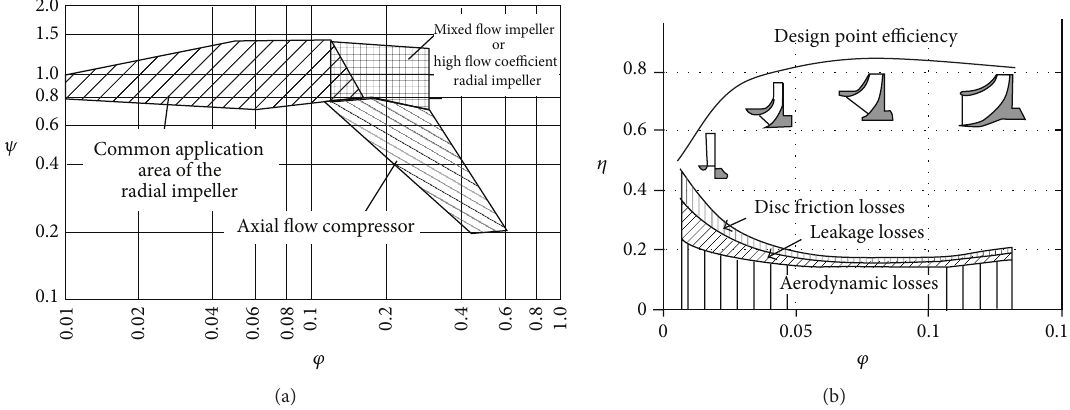
Figure 1: Application areas of high flow coefficient radial impellers and typical industrial compressors